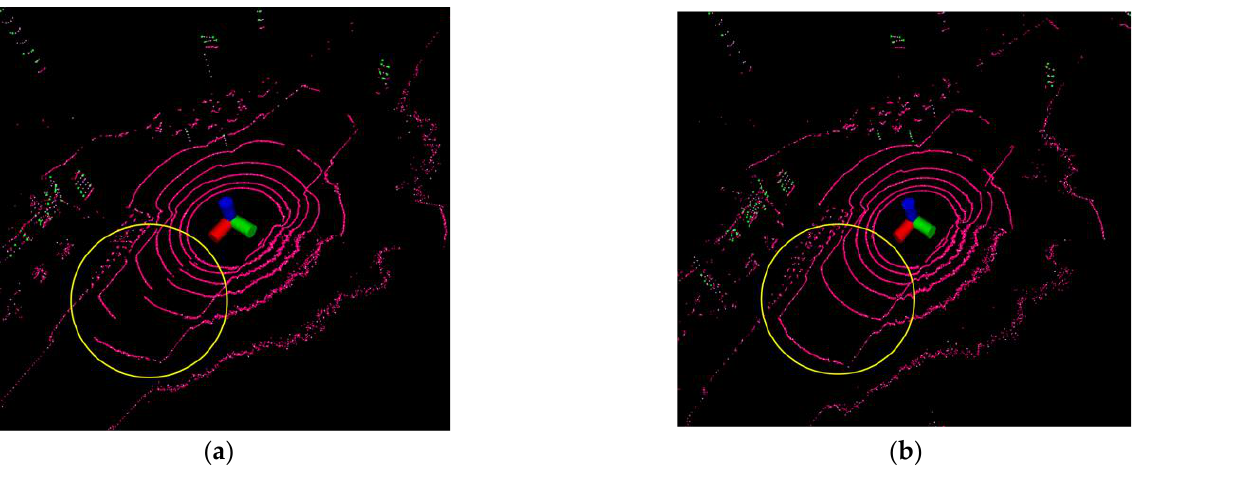
Figure 5. Point cloud distortion caused by translation. ( a ) Before distortion correction; ( b ) After distortion correction.